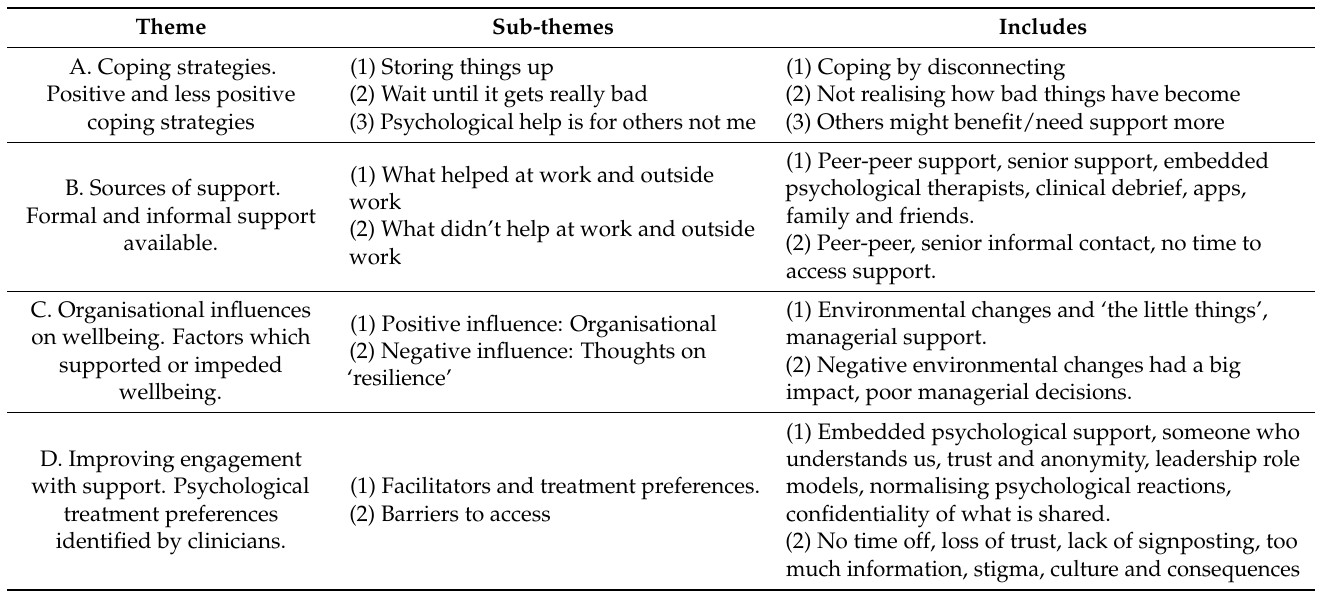
Table 3. Themes and